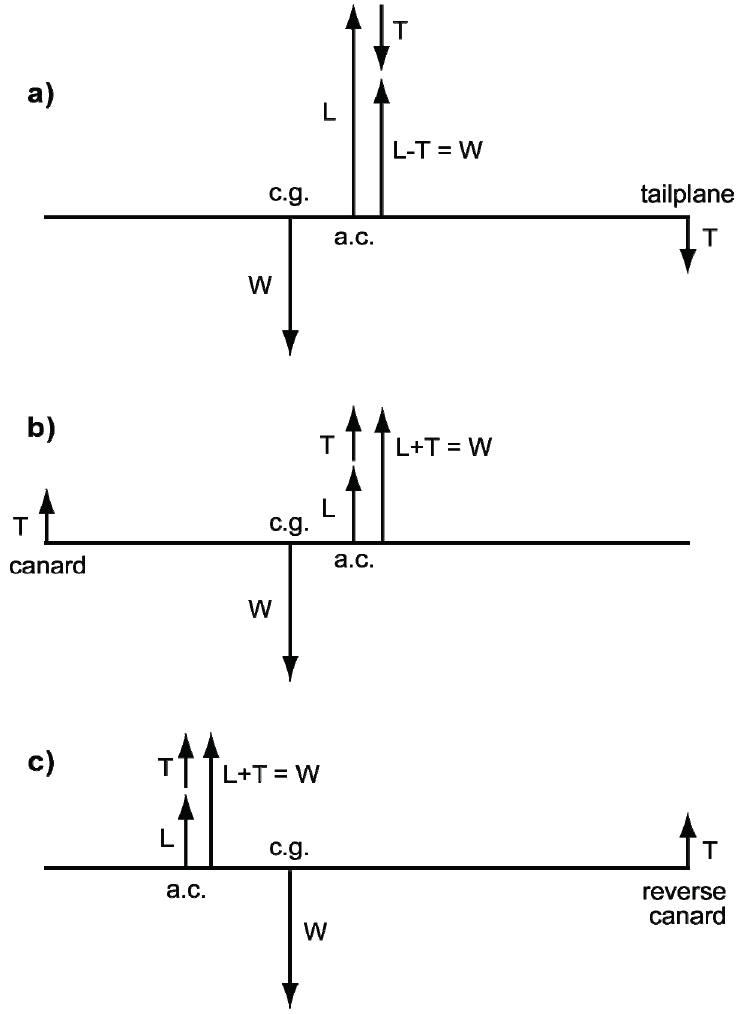
Figure 20. Pitch trim with lift augmentation in the reverse canard configuration. In a conventional aircraft ( a ) with aerodynamic center (a.c.) behind the center of gravity (c.g.) pitch trim reduces overall lift ( a ); this is particularly undesirable with a tailplane with